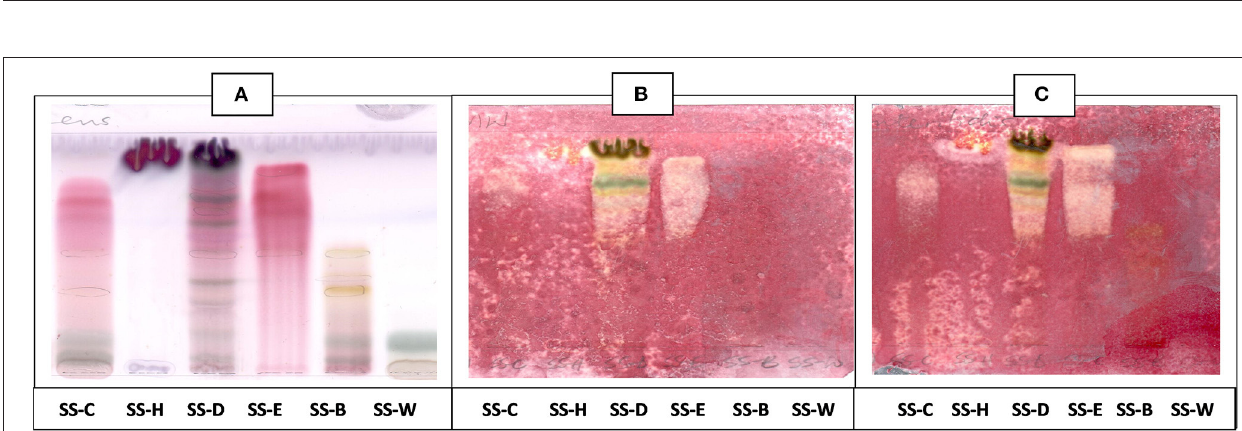
FIGURE 3 | (A) Chromatogram developed in CEF [chloroform: ethyl acetate: formic acid (5:4:1)] of S. singueana fractions sprayed with vanillin. (B) Bioautography of S. aureus –TLC plate developed with CEF (5:4:1). (C) Bioautography of S. Enteritidis –TLC plate developed with CEF (5:4:1). SS-C, S. singueana crude extract; SS-H, hexane fraction; SS-D, dichloromethane fraction; SS-E, ethyl acetate fraction; SS-B, butanol fraction; SS-W, Water fraction. White bands indicate compounds that inhibit bacteria.